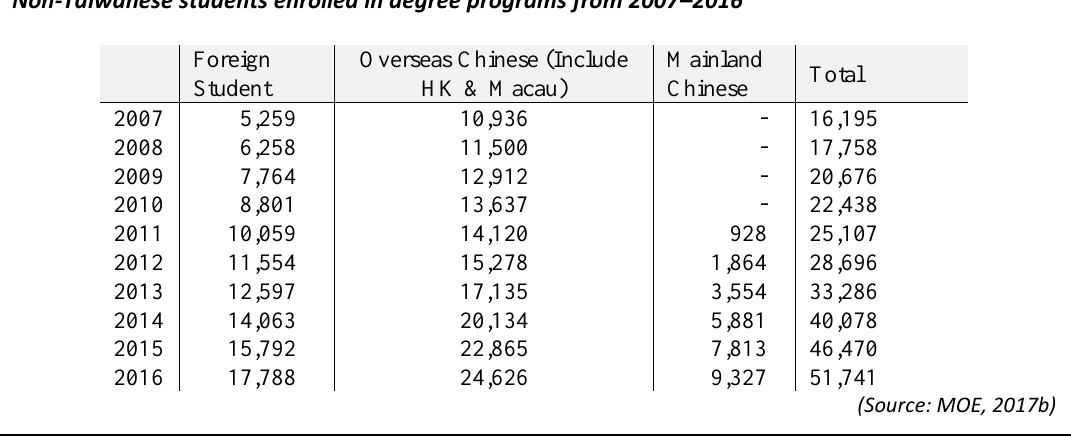
Non-Taiwanese students enrolled in degree programs from 2007 –